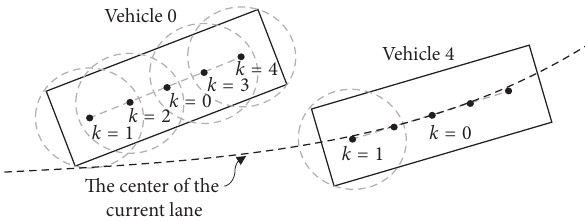
Figure 5: Decomposing a vehicle shape into five